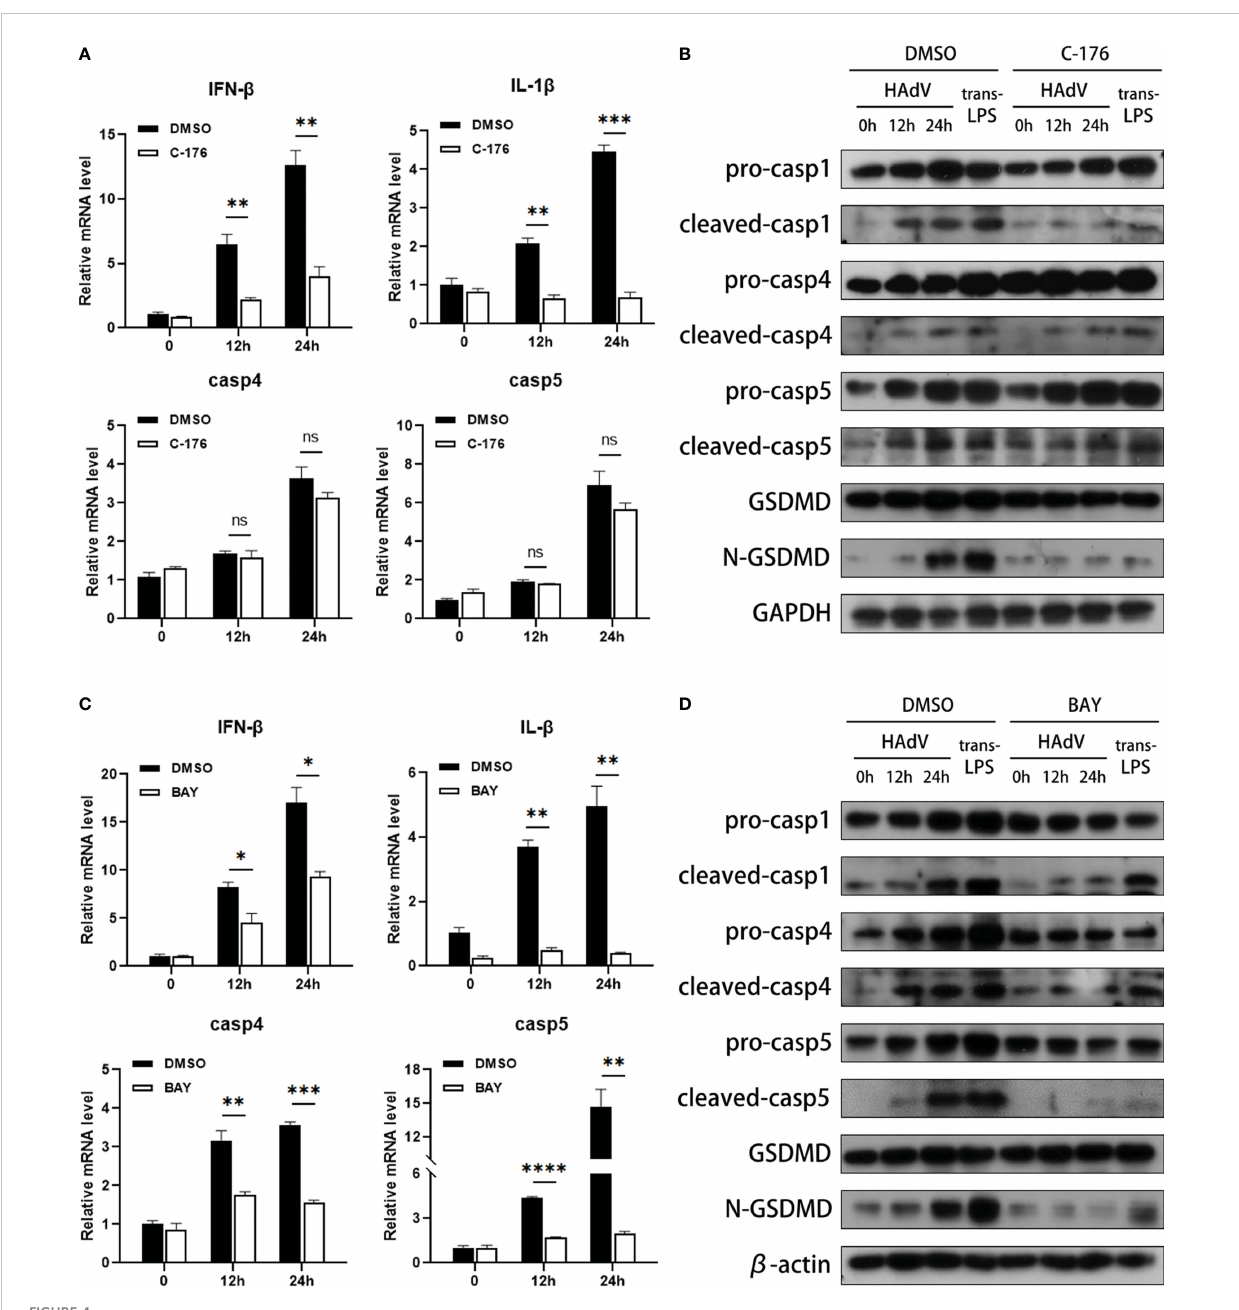
FIGURE 4 NF- k B was involved in noncanonical in fl ammasome activation and macrophage pyroptosis. The dTHP-1 cells pre-treated by either (A, B) C-176 (1 m M) or (C, D) BAY11-7082 (10nM) vs vehicle control (DMSO) were infected with HAdV (MOI=100) for the indicated times or transfected with LPS (2.5 m g/ml) for 8h. (A, C) The mRNA levels of IFN- b , IL-1 b , and caspase-4/5 were measured by real-time PCR. (B, D) Protein levels of indicated molecular in cell lysates were tested by western blot. Data are representative of at least three experiments. Error bars represent the mean ± SEM. * P value<0.05, ** P value <0.01, *** P value <0.001, **** P value <0.0001, ns, no signi fi